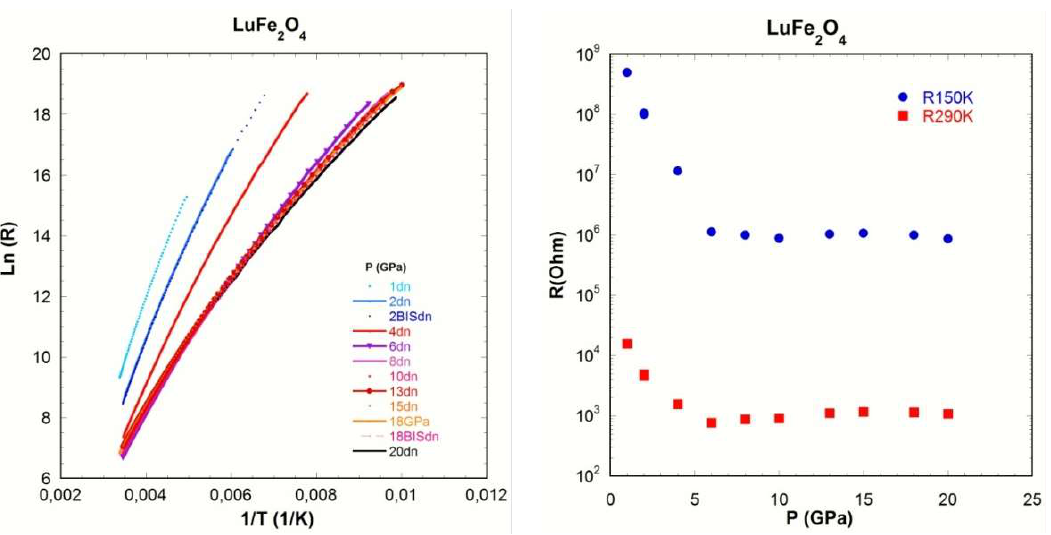
Figure 11. ( a ) Pressure dependence of resistivity measurements as a function temperature; ( b ) resistivity measurements as a function of pressure at 290 K and 150 K respectively.